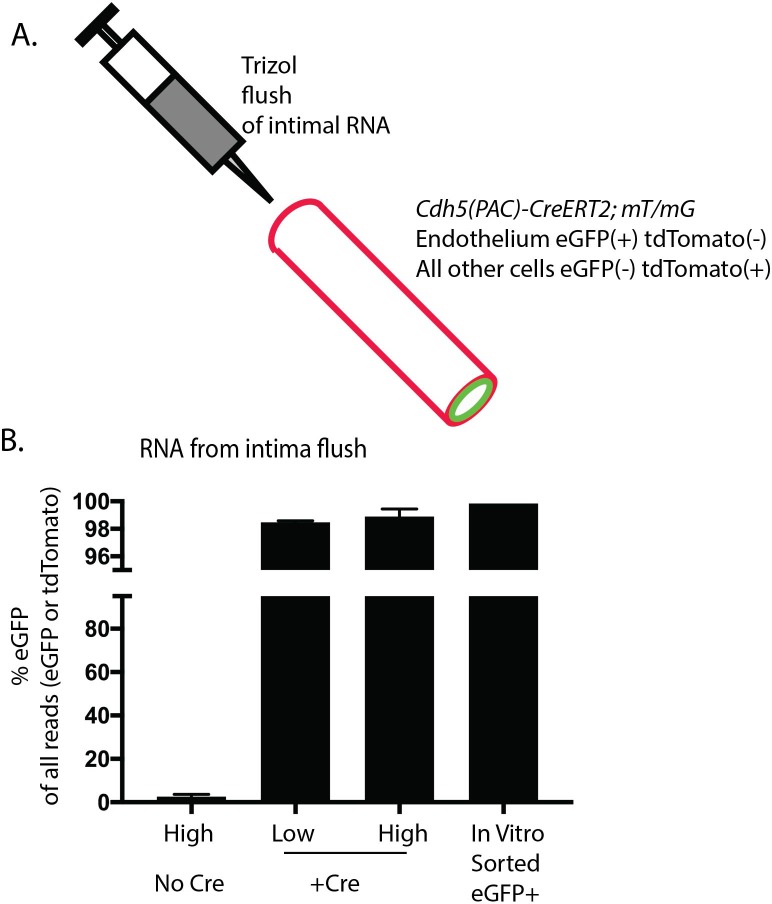
Enrichment of endothelial RNA demonstrated by lineage markers in mT/mG mice.The mT/mG mice constitutively express tdTomato in all cells from a CMV enhancer/chicken beta-actin core promoter (pCA). Upon Cre activity, in this case driven by the endothelial-specific Cdh5(PAC)-CreERT2, the tdTomato is excised, and a downstream eGFP is expressed instead. Since tdTomato is expressed in all non-endothelial cells and eGFP is expressed in all endothelial cells, the ratio may be used as an indicator of endothelial to non-endothelial mRNA levels in the isolate. The comparison of RNA-seq reads assigned to eGFP or tdTomato from Cdh5(PAC)-CreERT2; Rbfox2 ff; mT/mG (N = 2 pools) mice or Rbfox2 ff; mT/mG mice (N = 2 pools) is shown. Cultured and FACs-purified eGFP +cells from Cdh5(PAC)-CreERT2; Rbfox2 ff; mT/mG mouse aorta is also shown (N = 1).